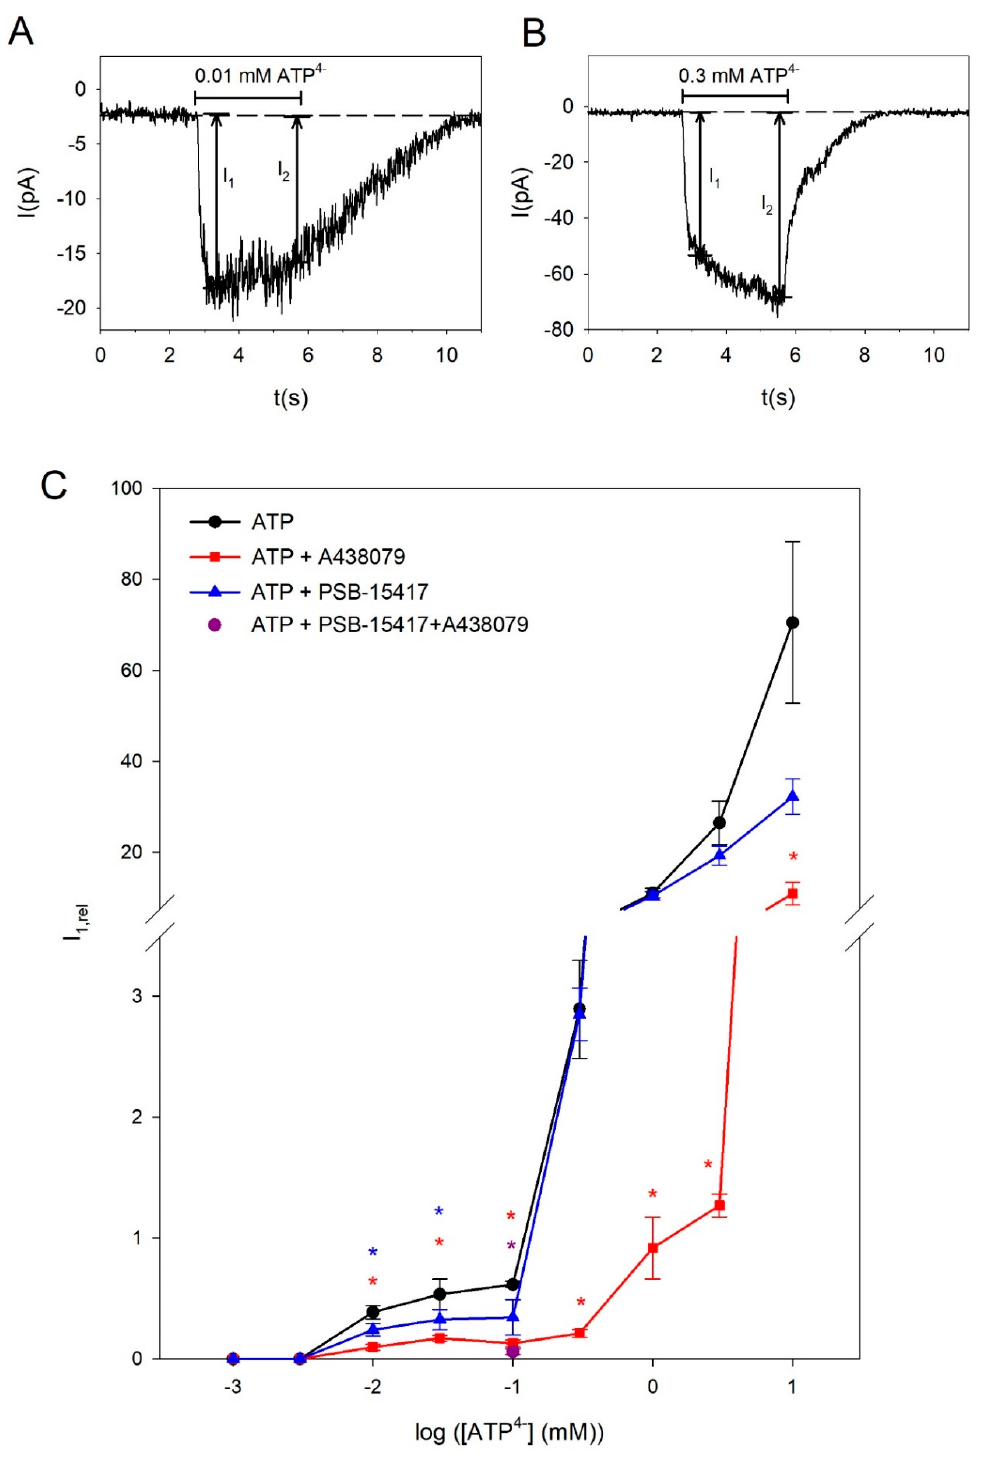
Figure 1. Concentration-dependence of ATP-induced currents in BV-2 microglia cells. ( A , B ) Representative current traces elicited by applying 0.01 mM or 0.3 mM ATP 4 − as indicated. The determination of I 1 and I 2 is illustrated. ( C ) The curves show the ATP 4 − concentration dependence in the absence and presence of 10 µM of the P2X4R blocker PSB-15417 or 10 µM of the P2X7R blocker A438079 as indicated. Current amplitudes I 1 were normalized to a preceding application of 0.1 mM ATP 4 − . Data are means ± SEM of 6–231 cells. Significant differences from the ATP 4 − alone curve are marked by asterisks (blue: PSB-15417, red: A438079).